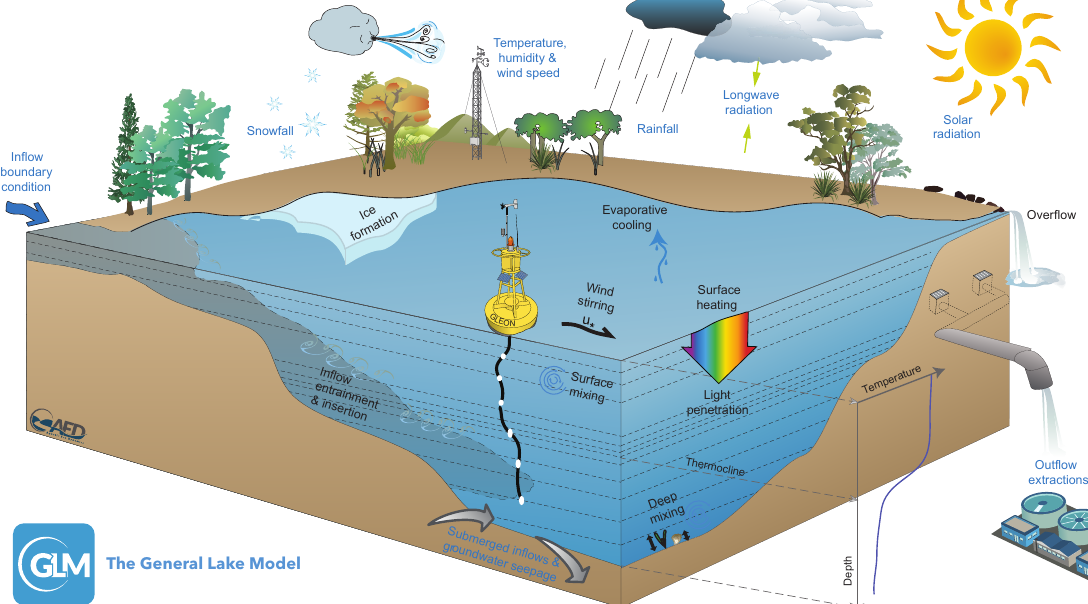
Figure 1. Schematic of a GLM simulation domain, input information (blue text), and key simulated processes (black text).